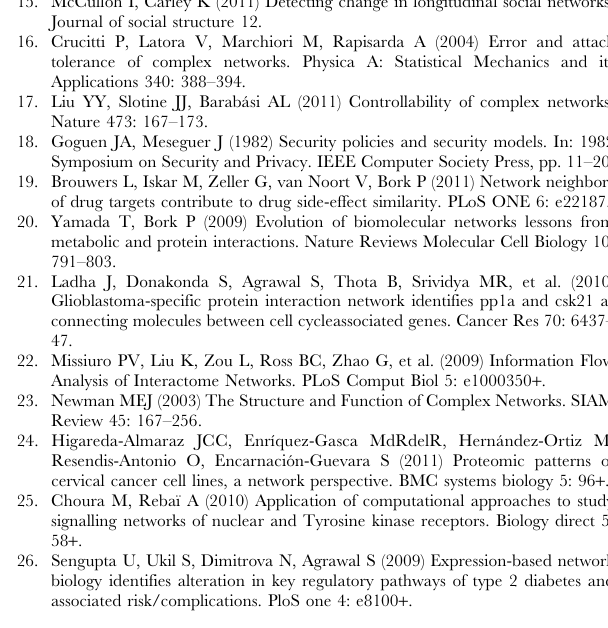
Table S1 Robustness analysis of JAK2 and SRC in the integrin activation network.